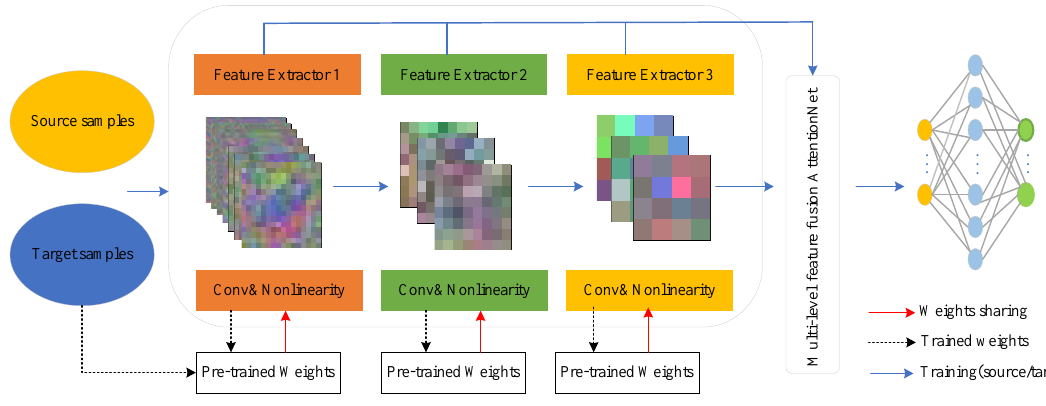
Figure 4. Transfer learning framework.